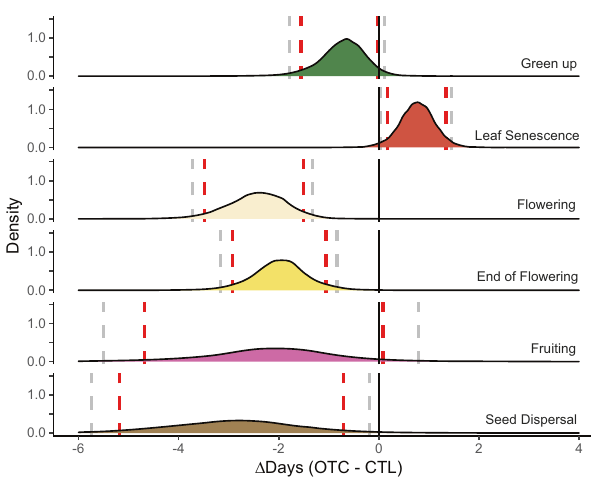
Fig. 3 Effects of experimental warming on phenology. Reproductive phenophases shifted with a greater magnitude than vegetative phenophases to experimental warming. Density plots of modeled estimates of treatment effects for the difference (in days) in phenophase timing for plants growing in OTC versus control (CTL) plots. Colors designate each of the 6 measured phenophases. Estimates are shown on the x axis and phenophases are plotted vertically including data from all sites, years, and species as modeled using Eq. 2. Black vertical lines denote zero difference (no change) in the timing of phenology between OTC and CTL plots while red and gray dashed lines denote the 90% and 95% Bayesian credible intervals, respectively. Peaks to the left of black lines indicate an advancement, while peaks to the right of black lines indicate a delay, of that phenophase in response to warming. Created using the ggplot2 package (v 3.3.2) 106 in